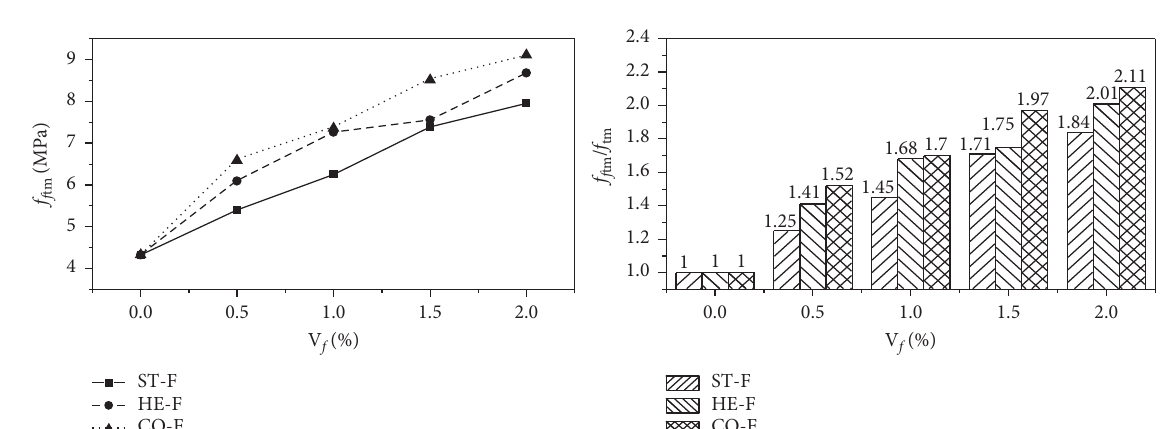
Figure 7: Relationship between f